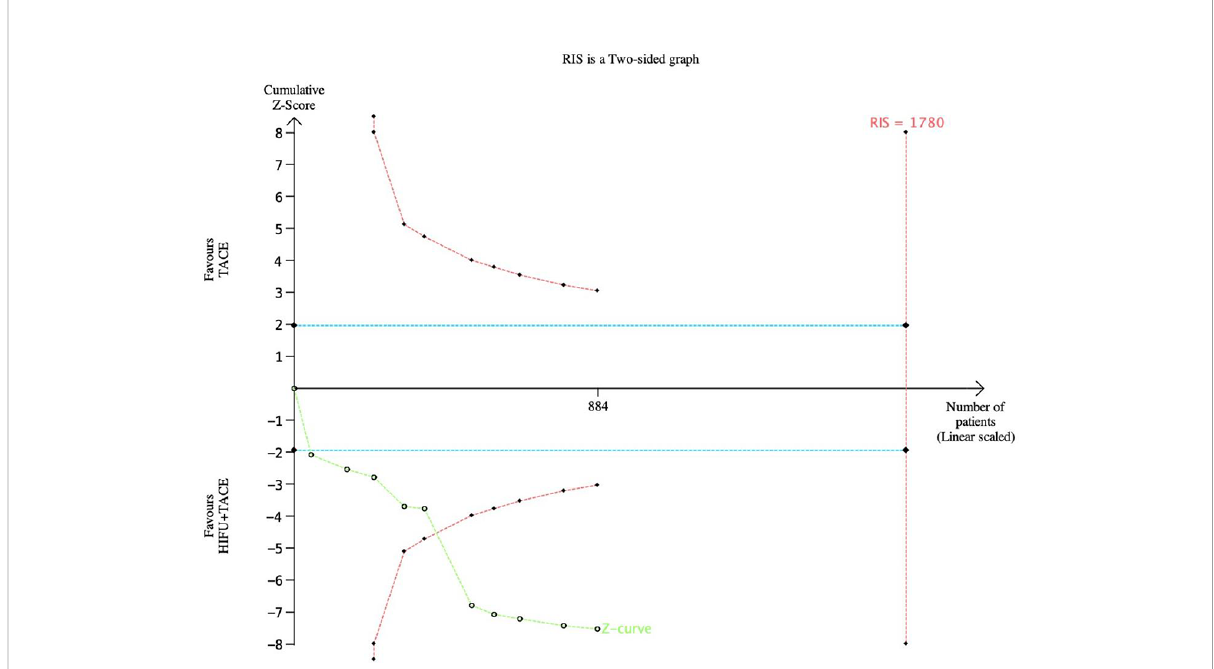
FIGURE 13 TSA gragh of one-year survival rate. The pink line represents RIS, the blue line represents the traditional bound, and the green line represents the Z curve.